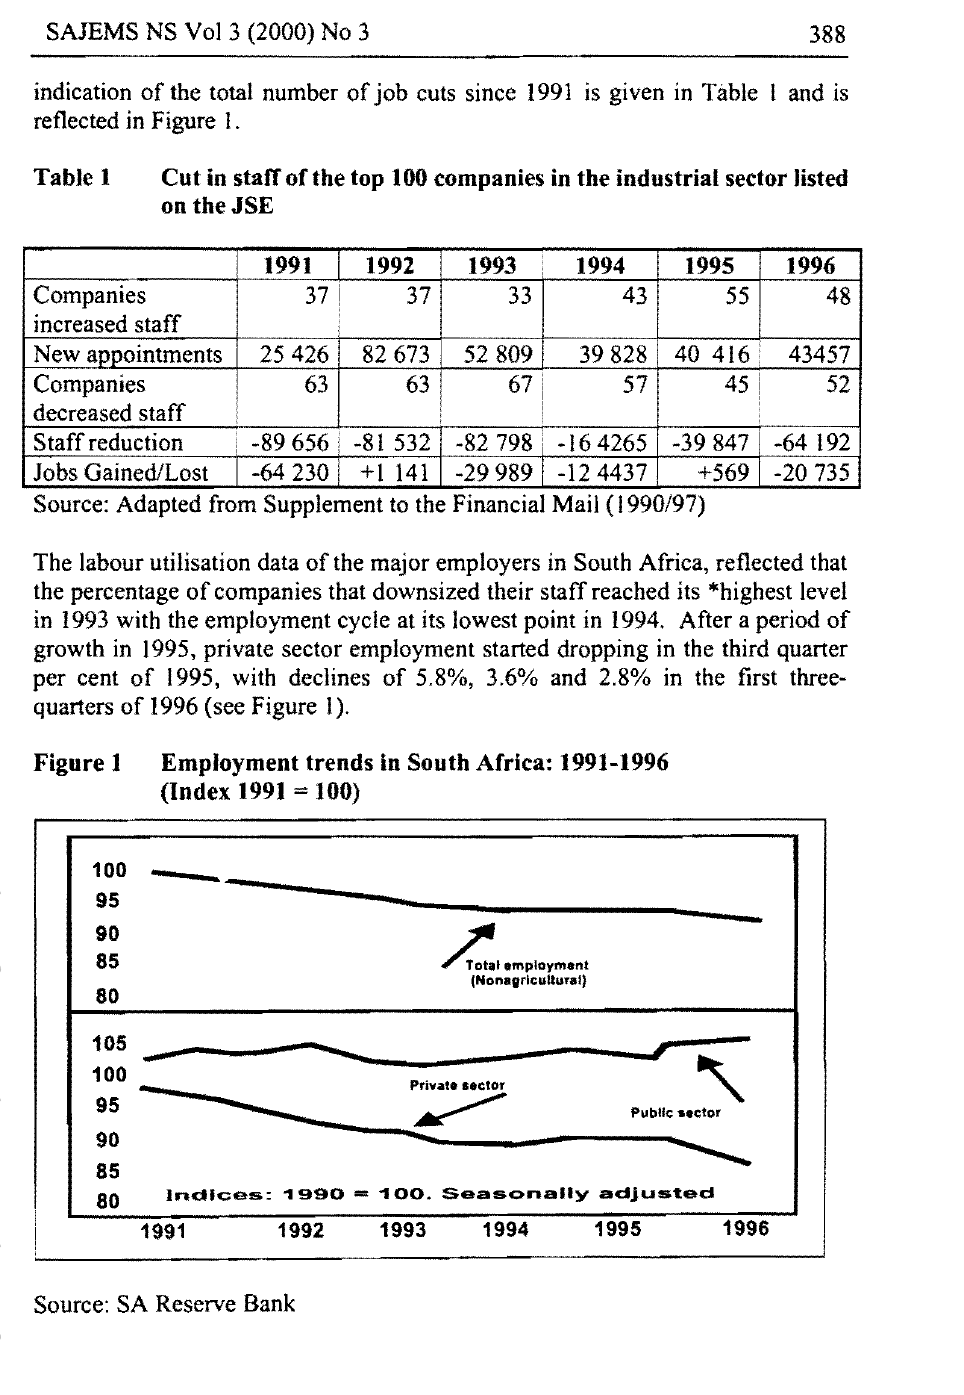
Cut in staff of the top 100 companies in the industrial sector listed on theJSE